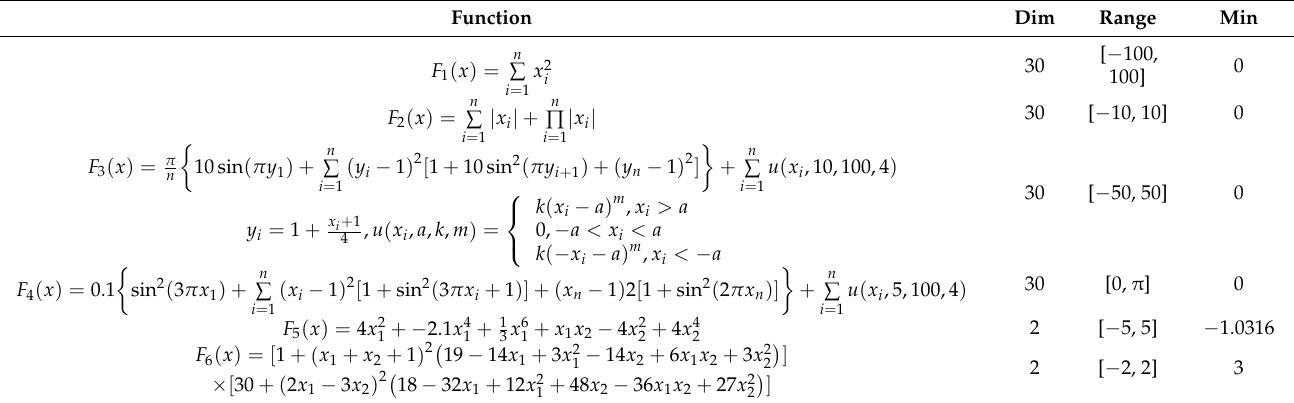
Table 4. Details of the test functions.